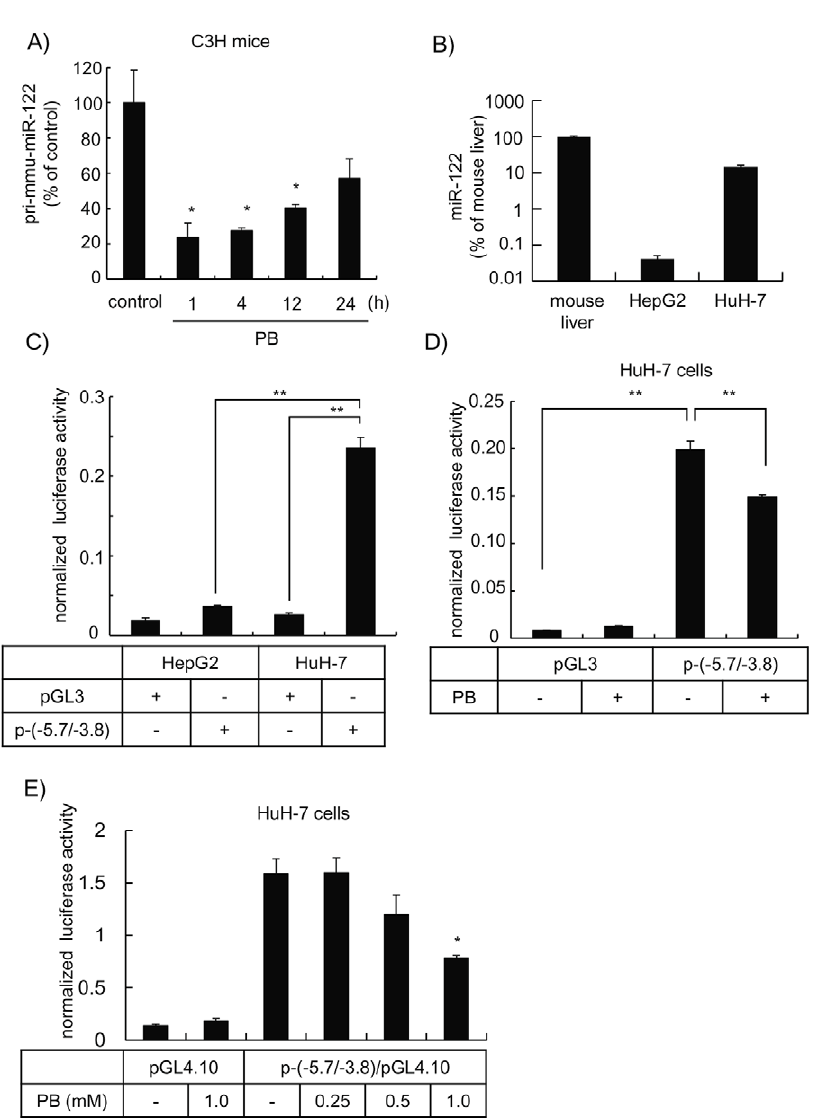
Figure 2. PB induces the down-regulation of miR-122 at the transcriptional level. A , Total RNA from liver of mice treated with PB (100 mg/ kg, ip. ) was subjected to quantitative RT-PCR using a TaqMan probe for pri-miR-122. Data normalized with the respective U6 snRNA are presented as the % of control group (n=3). *, p , 0.05. B , Total RNA samples from mouse liver, HepG2 and HuH-7 cells were subjected to quantitative RT-PCR using a TaqMan probe for mouse or human miR-122. Data were normalized with respective U6 snRNA and are presented as the % of mouse liver (n=3). C , HepG2 and HuH-7 cells seeded in 24-well multi-dish (1.5 6 10 5 cells/well) were transfected with 0.9 m g of either pGL3 basic or p-( 2 5.7/ 2 3.8) vector along with 0.1 m g phRL-TK vector. Firefly luciferase activity determined 48 h after the transfection was normalized with respective Ranilla luciferase activity (n=3). **, p , 0.01. D , HuH-7 cells seeded in 24-well multi-dish were transfected either with 0.9 m g of either pGL3 basic or p-( 2 5.7/ 2 3.8) vector along with 0.1 m g phRL-TK vector and were treated with 1 mM PB 12 h later. Firefly luciferase activity determined 48 h after the transfection was normalized with respective Ranilla luciferase activity (n=3). **, p , 0.01. E , HuH-7 cells seeded in 96-well multi-dish (3 6 10 4 cells/well) were transfected with 0.1 m g of either pGL4.10 or p-( 2 5.7/ 2 3.8)/pGL4.10 vector along with 0.01 m g pGL4.74 and 0.09 m g pcDNA3.1 vectors and were treated with PB at concentrations illustrated 12 h later. Firefly luciferase activity which was determined 48 h after the transfection was normalized with respective Ranilla luciferase activity (n=4). *, p ,